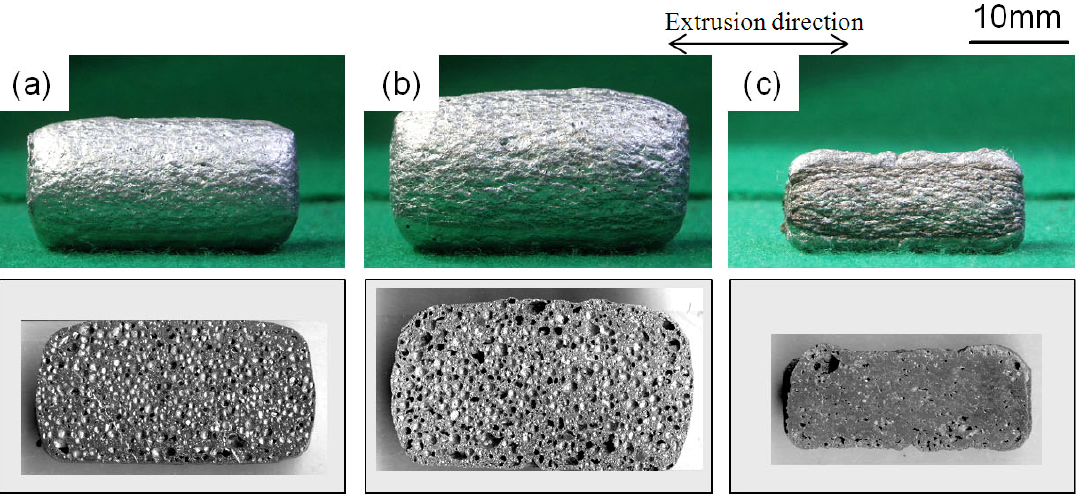
Figure 3. Foams produced using 2.0 mass% dolomite and their cross sectional views: ( a ) at 943 K, ρ : 0.88 g/cm 3 , ( b ) at 958 K, ρ : 0.60 g/cm 3 , and ( c ) at 968 K, ρ : 1.61 g/cm 3 .